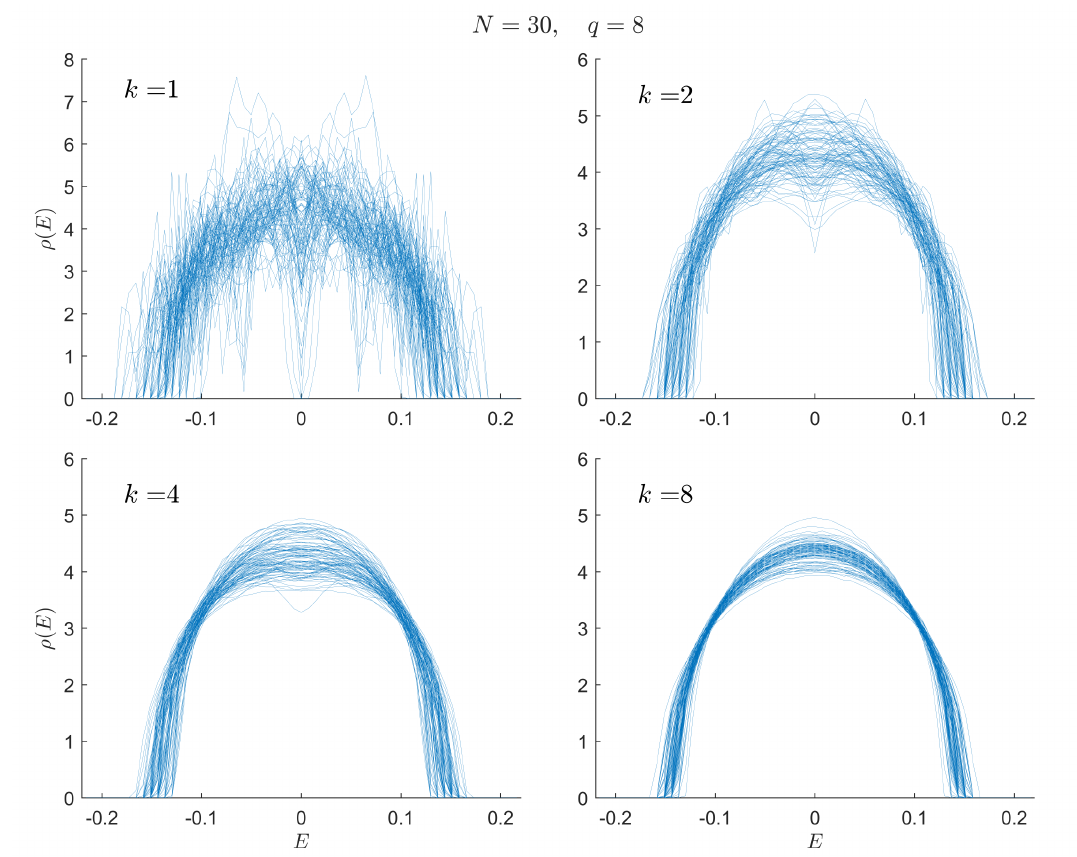
Figure 11 . The spread of the spectral density of the sparse SYK Hamiltonian for 100 disorder realizations and for various values of k